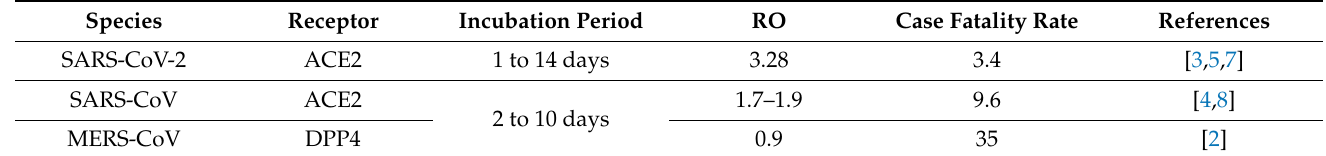
Table 1. Pathogenetic and epidemiological characteristics of SARS-CoV-2, SARS-CoV and MERS-CoV. Species Receptor Incubation Period RO Case Fatality Rate